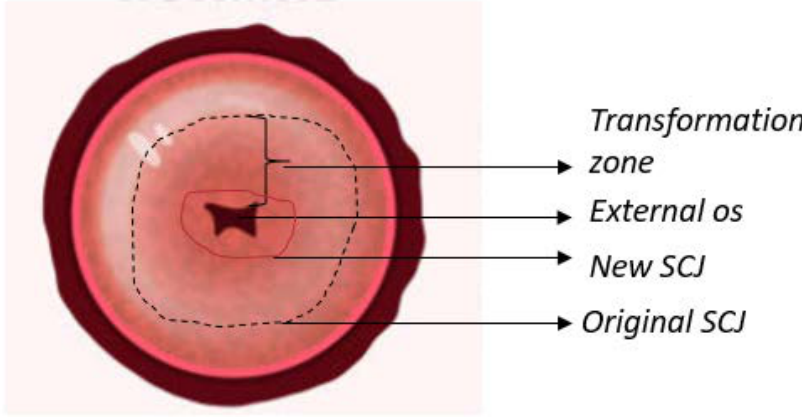
Figure 1. Anatomy of the uterine cervix highlighting the epithelium found on the surface, as well as the transformation zone and squamocolumnar junction (SCJ). the transformation zone and squamocolumnar junction